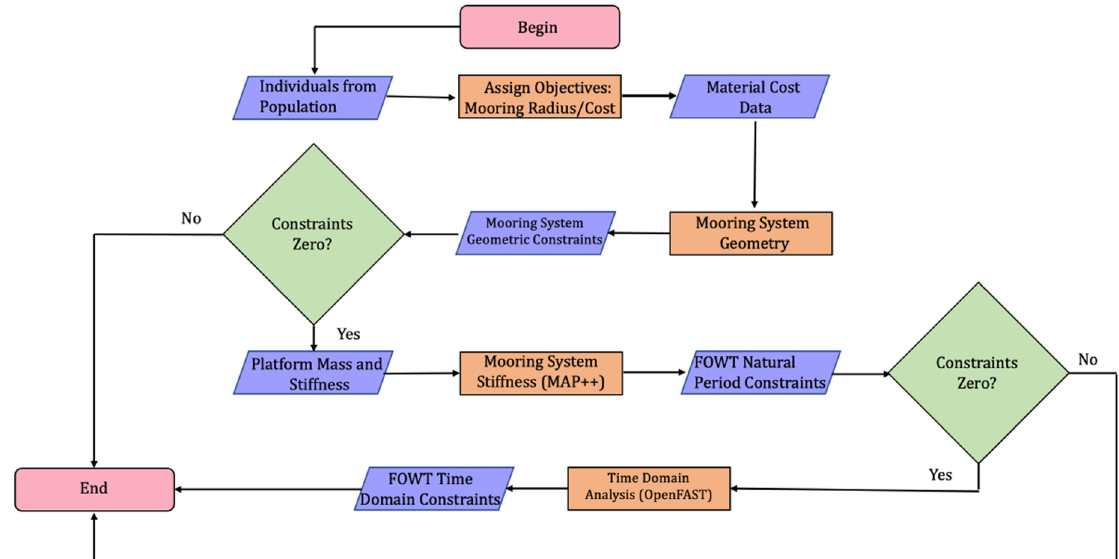
Figure 2. Constraint and Objective Calculation Flow Chart .